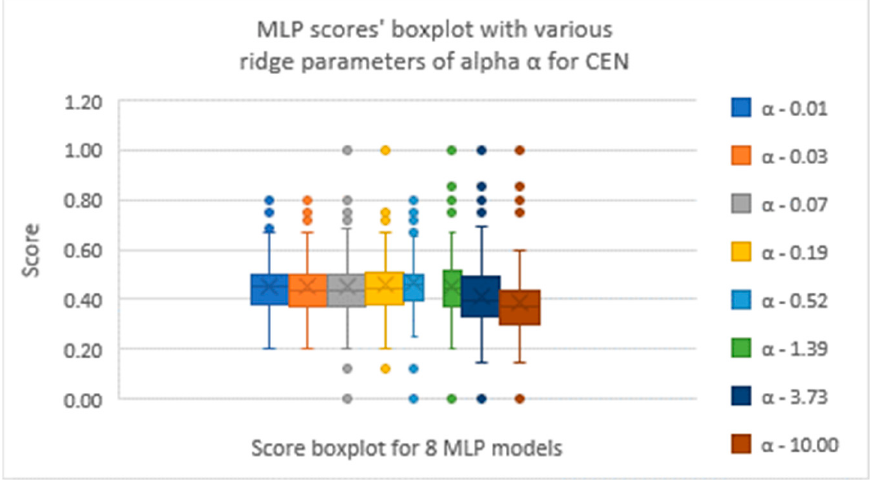
Figure 3. Variation in MLP prediction performance with elevation and α in CEN.